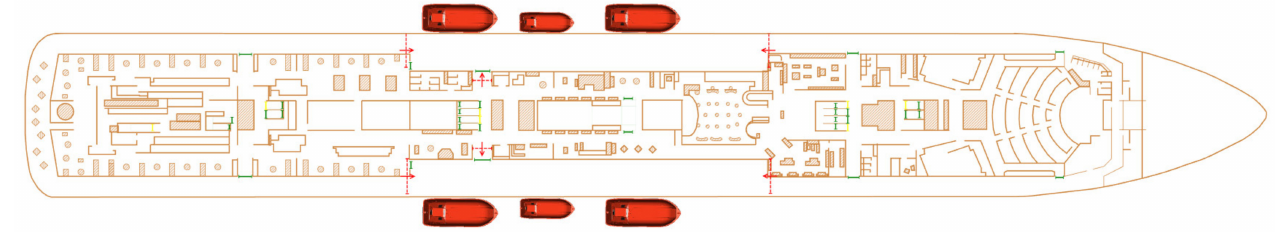
Figure 6. The space model of Deck 2.